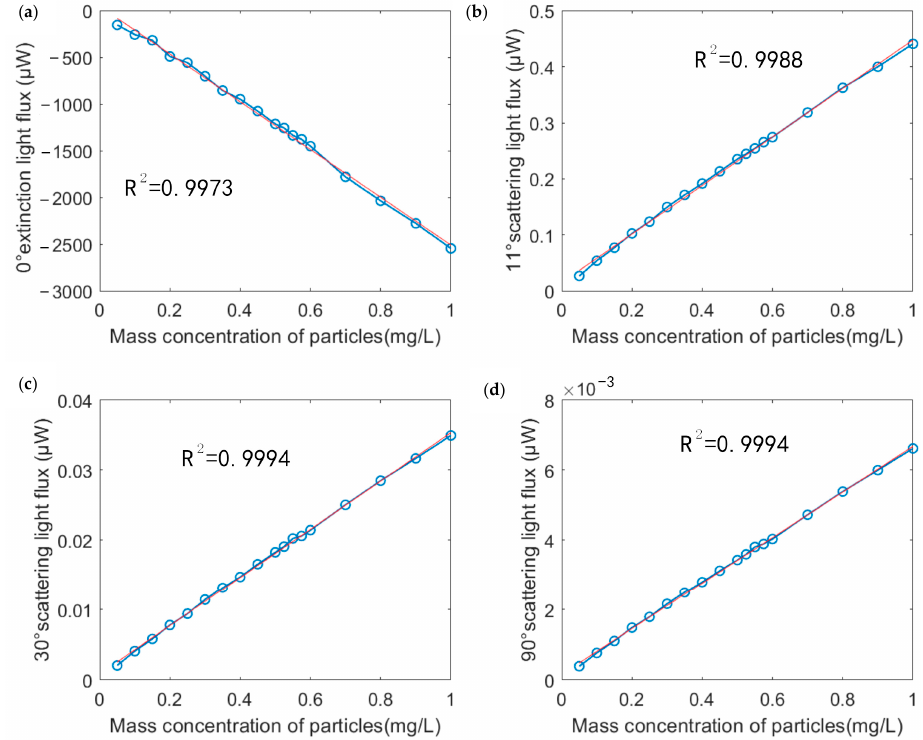
Figure 14. The fitting of the mass concentration and light flux of 0.5 μ m copper particles at ( a ) 0° ( b ) 11° ( c ) 30° and ( d ) 90°. In addition to 0.5 μ m copper particles, experiments were also performed based on the same method using copper particles with average particle sizes of 1 μ m, 3 μ m, 5 μ m, and 10 μ m. Figure 15a shows the relationship between particle mass concentration and transmitted light flux attenuation for copper particles of different average particle sizes. For different diameters of copper particles, the experimental data showed good linearity: the transmitted light flux decreases with the increase in particle size with the same particle mass concentration. Figure 15b–d show that the scattered light flux decreases as particle size increases while particle mass concentration remains constant. The above experi- mental results were similar to the theoretical calculations and had the same trend of vari- ation.